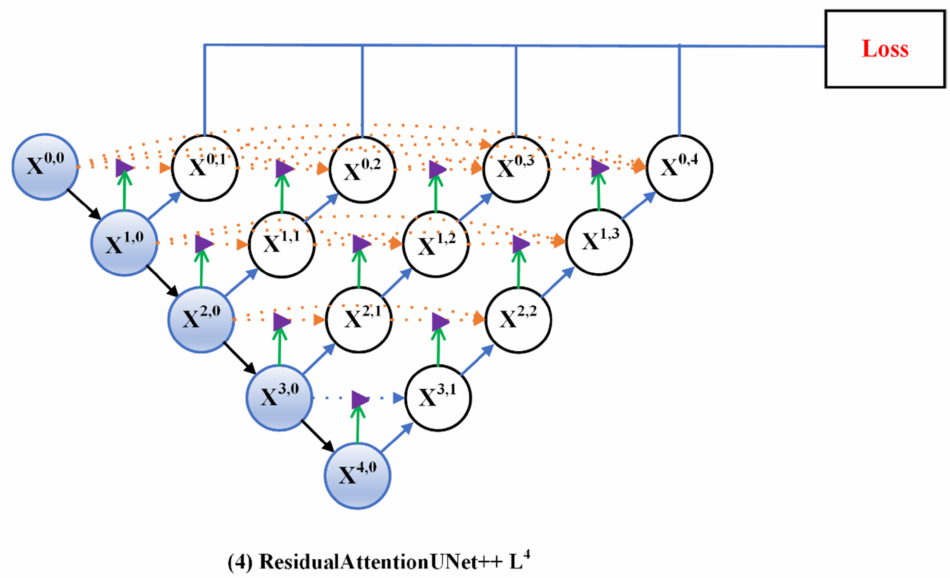
Figure 9. Residual-Attention UNet++ can be pruned to Residual-Attention UNet++ L 4 if trained with deep